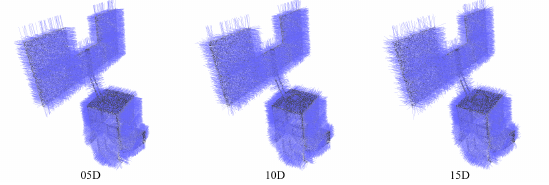
Figure 6. Point clouds with normals rendered. Point clouds of spacecraft Helios with different direction noise